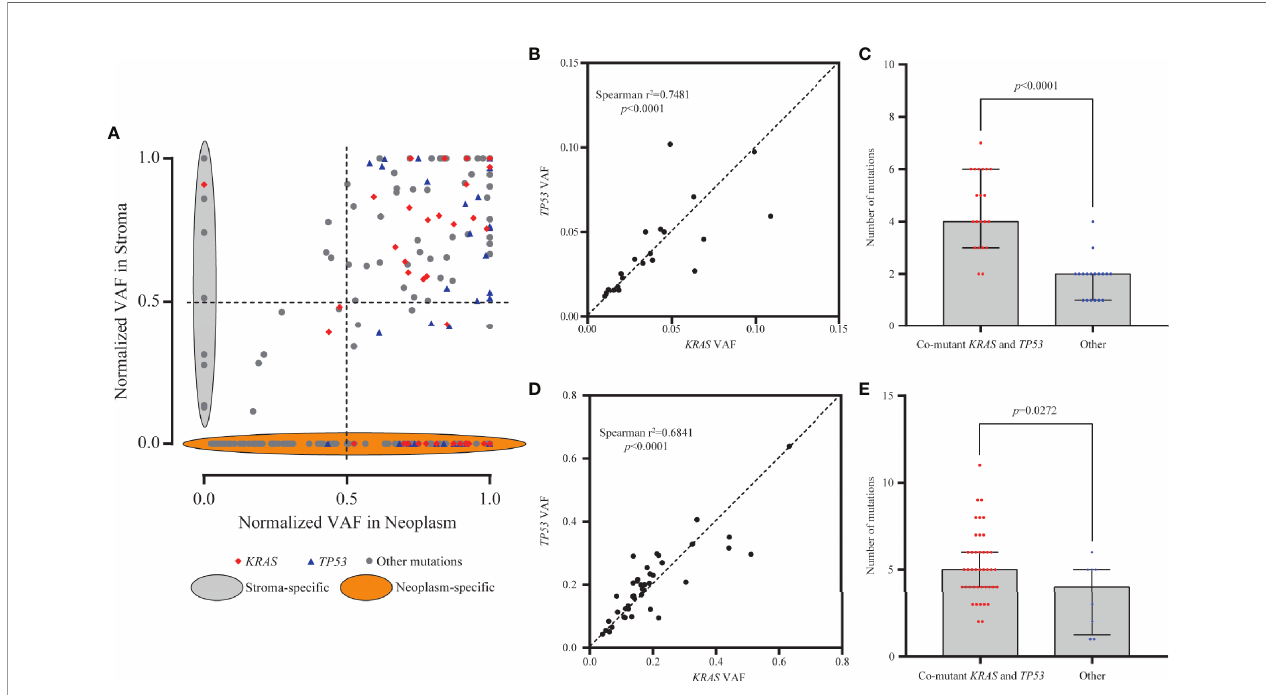
FIGURE 3 | Clonality and mutation burden analysis of KRAS in stromal and neoplastic components. (A) Variant allele frequencies (VAFs) of each mutation were normalized with maximum VAF in the same specimen to assess the clonality. Mutations with ≥ 50% normalized VAFs were more likely to be clonal events; 86.8% of common mutations were clonal events in stroma. (B, D) The VAFs of KRAS and TP53 mutations showed statistically signi fi cant consistency in the stromal (Spearman ’ s r 2 = 0.7481, p < 0.0001) and neoplastic (Spearman ’ s r 2 = 0.6841, p < 0.0001) components, indicating that mutants KRAS and TP53 might have co-occurred around the same early period. (C, E) Samples with co-mutants KRAS and TP53 tended to harbor more mutations than the other mutant subtype samples, in both stromal ( p < 0.0001) and neoplastic ( p = 0.0272)